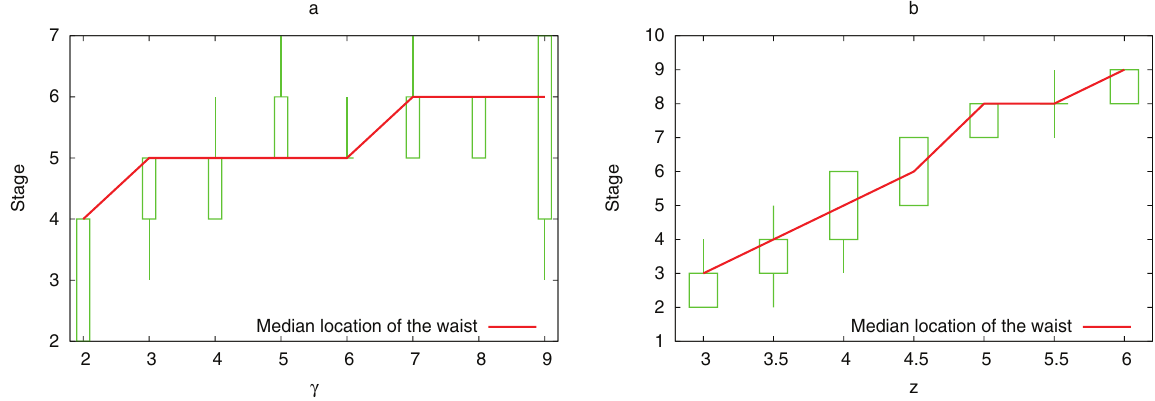
Figure 10. We examine the effect of the two model parameters that affect the location of the DGEN hourglass waist. The first is the specificity function. To examine its effect, we use a sigmoid-like mathematical function that controls the stage γ at which the specificity is 50% (see Figure 9). This is the stage with the maximum variance in the number of outgoing regulatory edges. RW events at this stage can cause the largest extent of rewiring and so, the highest likelihood of RFs in genes of the next stage. Graph ( a ) shows that the location of the hourglass waist is “pushed” towards stage γ , even though it is not always exactly at that stage. The second way to affect the location of the hourglass waist is the parameter z that controls the shape of the RF probability. Increasing z makes RF events more likely, also increasing the likelihood of lethal RF cascades. Graph ( b ) shows that as we increase z the hourglass waist moves towards later developmental stages. These results are obtained using Model-2. Parameters: 10 runs with different initial populations, N = 1000 individuals, L = 10 stages, specificity function s ( l )